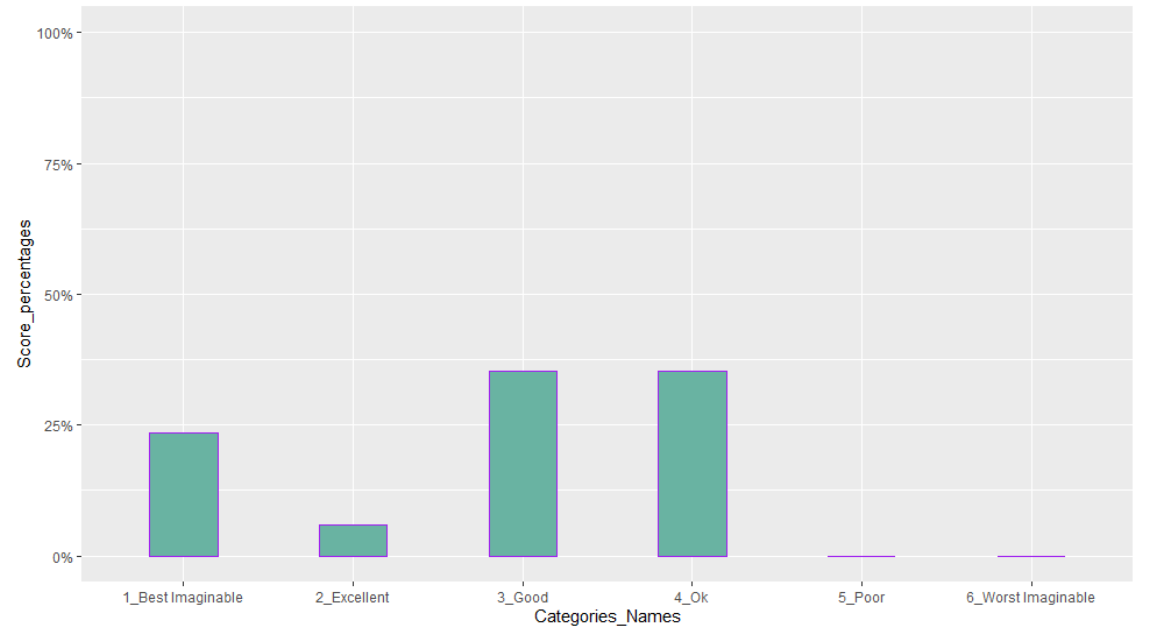
Figure 15. Percentages of ratings for each category from the System Usability Scale (SUS) questionnaire, categories from left to right are: best imaginable (score > 84.1); excellent (72.6 < score < 84.0); good (62.7 < score < 72.5); ok (51.7 < score < 62.6); poor (26 < score < 51.6); worst imaginable (score < 25).